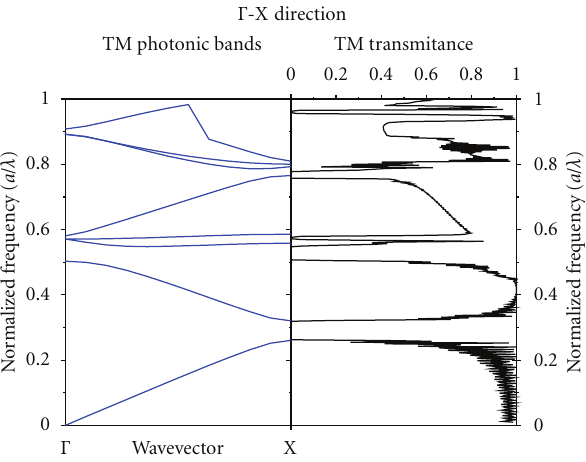
Figure 6: On the left, TM bands along the Γ -X direction for a 2D structure with a PSi layer of 40% porosity ( ε = 4 . 84) are represented. On the right pane, TM transmittance response for the same structure in the same direction is shown. In both graphs, the frequency is given in normalized units ( a/λ ).